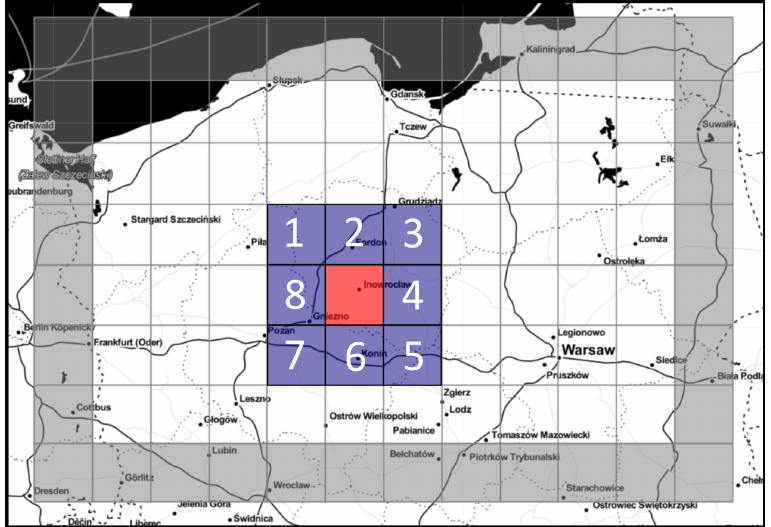
Figure 1. Storm nowcasting area. The input data contains the 3 previous hours of GNSS tomography and IWV data from the prediction area (red box) and the neighbourhood (blue boxes). Grey boxes are excluded from the predictions, however, they are taken into account as the